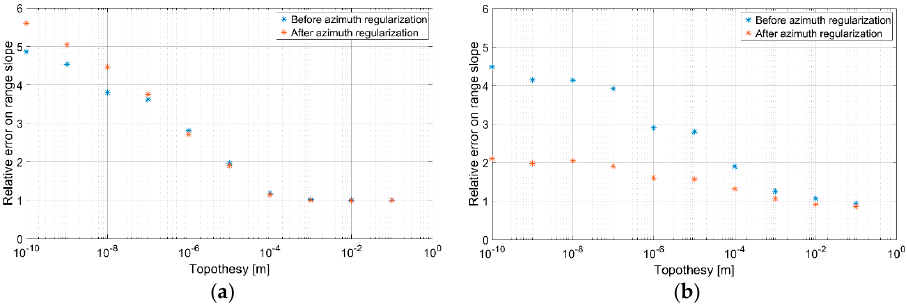
Figure 4. Range slope error neglecting ( a ) ε r or ( b ) H variations normalized to the range slope error committed with a priori knowledge about ( a ) dielectric or ( b ) roughness variations.